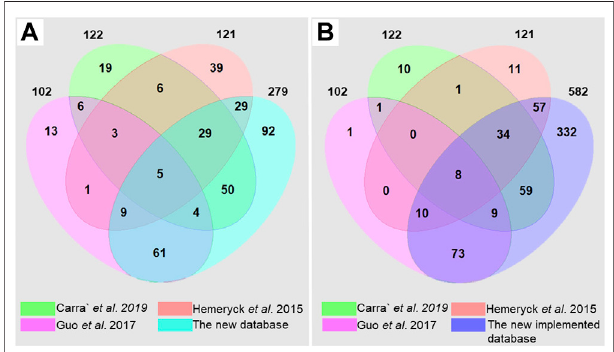
FIGURE 3 | Venn diagrams obtained by comparison of the DNA adduct databases of (Carrà et al., 2019a) (Hemeryck et al., 2015), (Guo et al., 2017) and the current database, (A) built upon literature search and (B) after implementation with suspected DNA